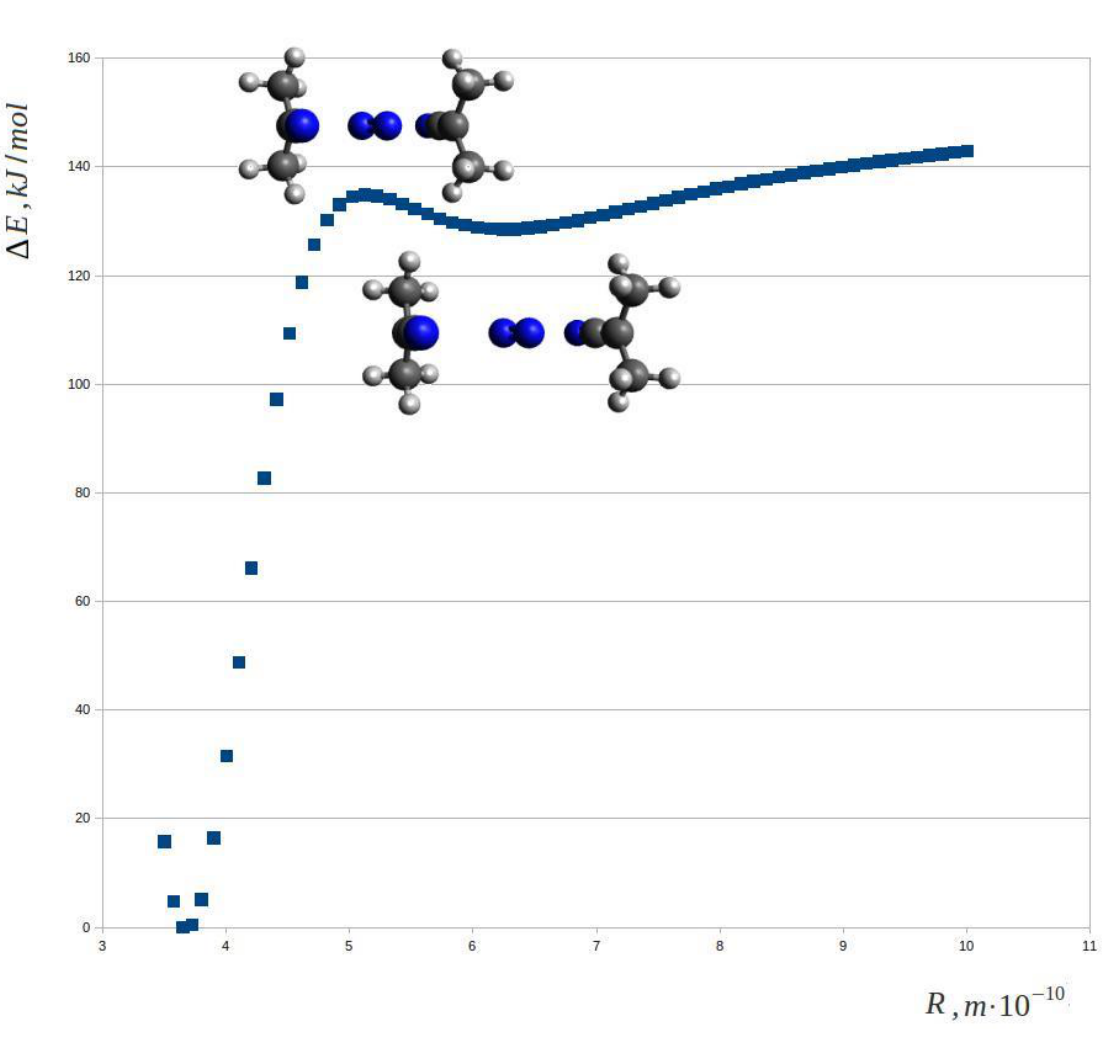
Figure 2. The dependence of the energy changes relative to the global minimum of the AIBN molecule in the singlet state on the distance between carbon atoms C1 and C5 (Figure 1).